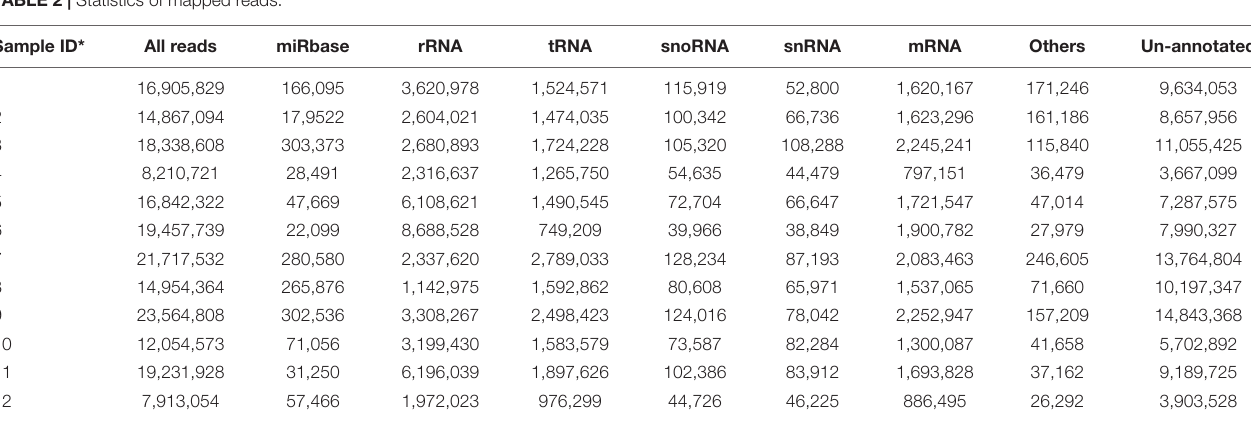
TABLE 2 | Statistics of mapped